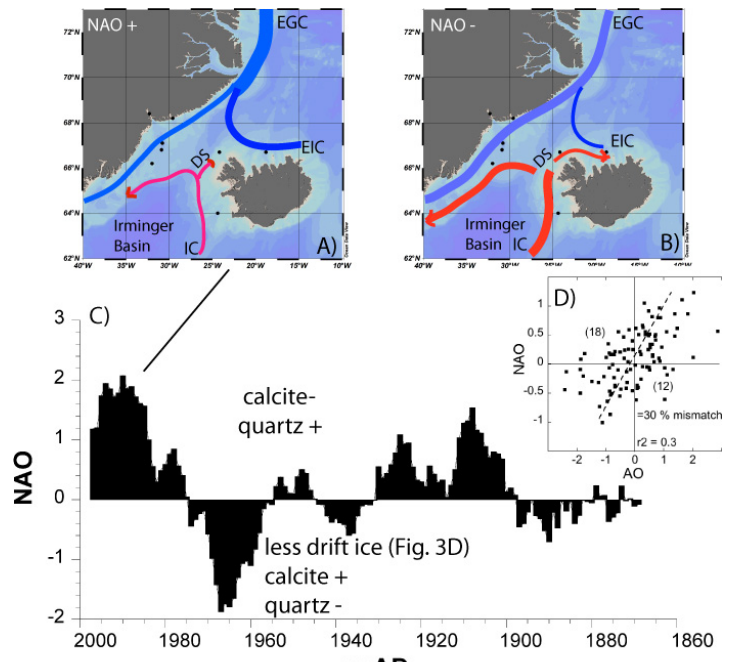
Fig. 2. EGC=East Greenland current; EIC=East Iceland current; IC=Irminger current. Core sites (Fig. 1) are shown as small dots. (A) Schematic plot of surface currents in the area of Denmark Strait (DS) under the influence of a NAO positive regime, and (B) NAO negative regime (after Blindheim et al., 2001). (C) Variations in the NAO winter index – data smoothed with a 10yr running mean. (D) Plot of the annual indexes for the AO and NAO